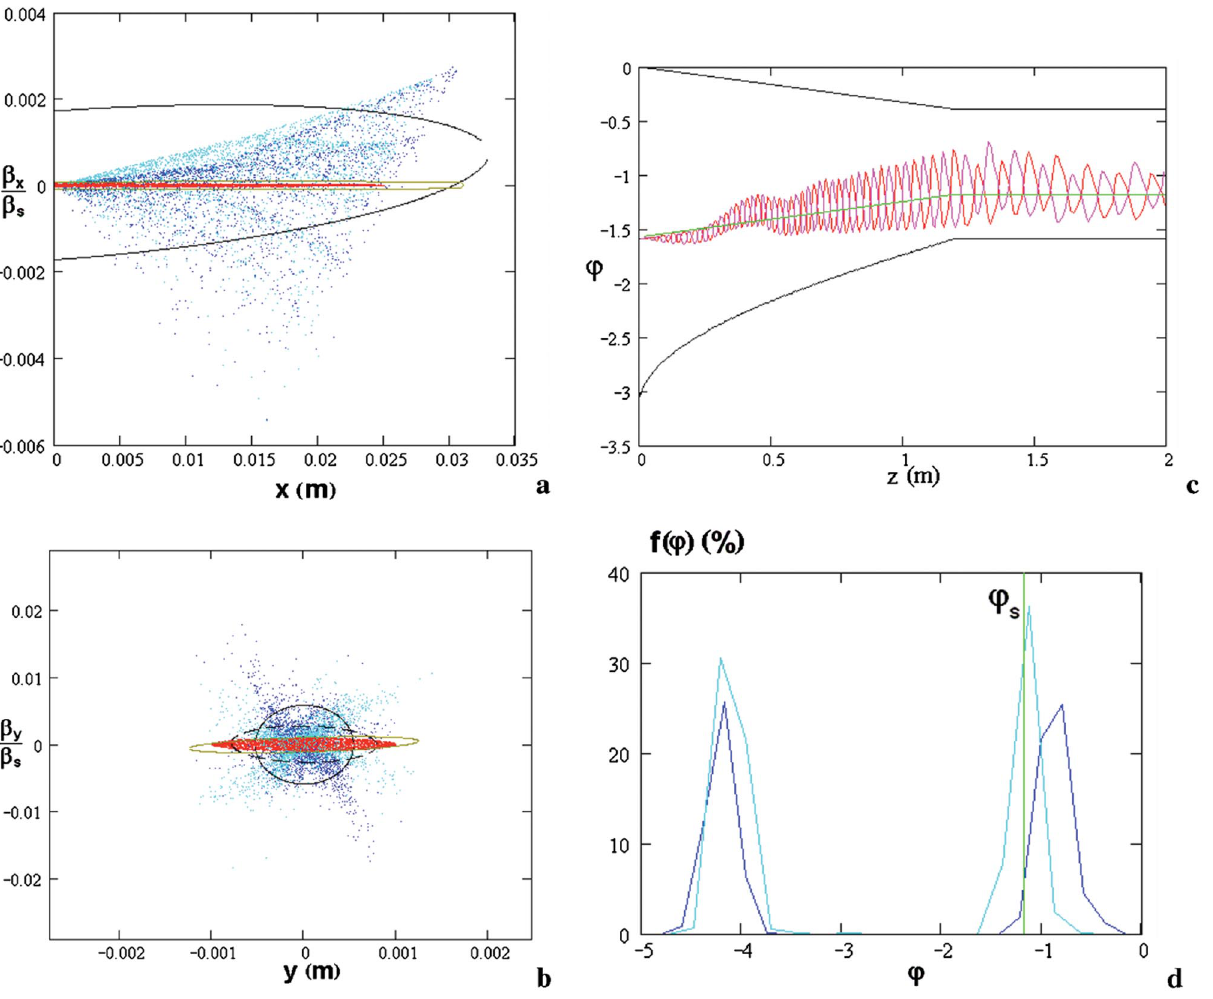
FIG. 7. (Color) The input and output dual beam parameters: (a) input and output normalized transverse emittances in the (cid:2) x; (cid:4) (b) input and output normalized transverse emittances in the (cid:2) y; (cid:4) types; (d) output phase spectra for D (cid:5) and D (cid:7)